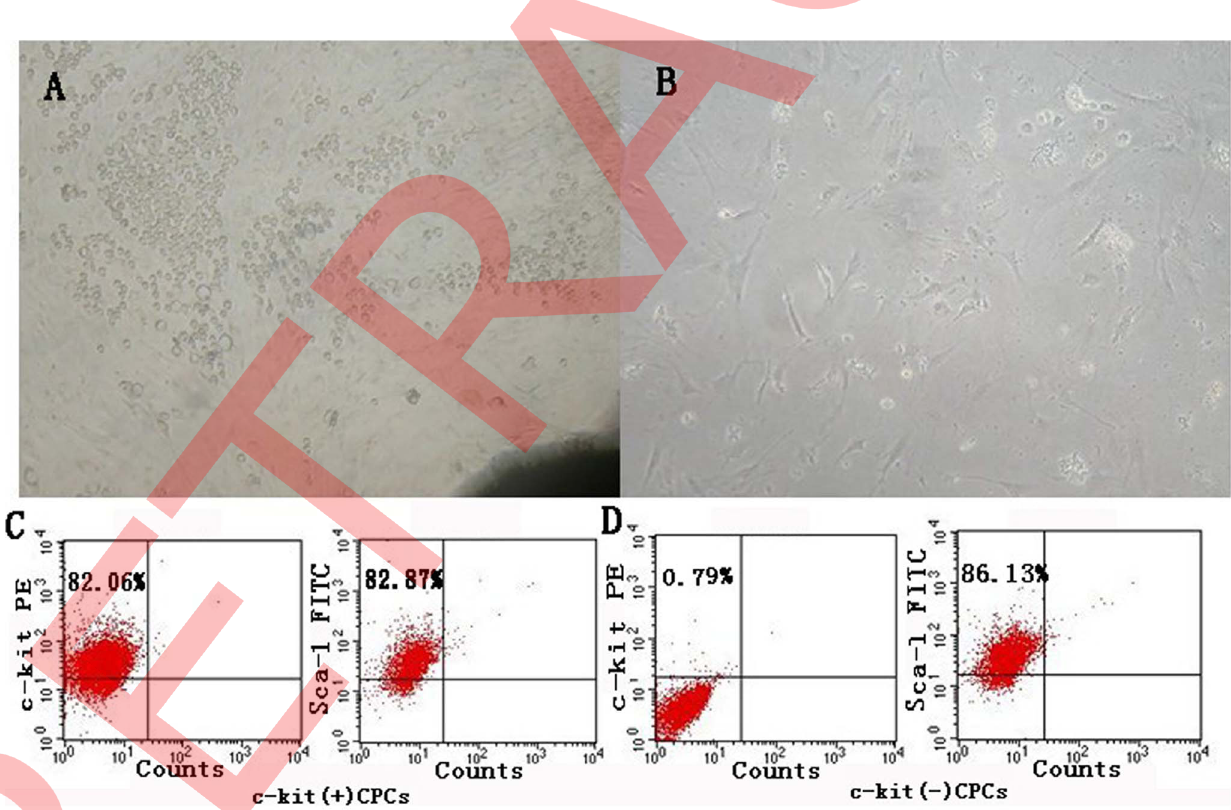
Figure 1. Characterization of cultured CPCs. (A) Cells (small, round, and phase-bright) migrated from the cardiac explants, and aggregated and proliferated on the fibroblast layer after 10 days of culture ( 6 100 magnification). (B) Representative clone generated by CPCs ( 6 100 magnification). (C) and (D) Representative flow cytometric analyses of c-kit( + )CPCs and c-kit( 2 )CPCs for the expression of the cell surface markers, namely, c-kit, and Sca-1. The Figure 1 panels A and B are excluded from the article's CC-BY license. See the accompanying retraction notice for more information .